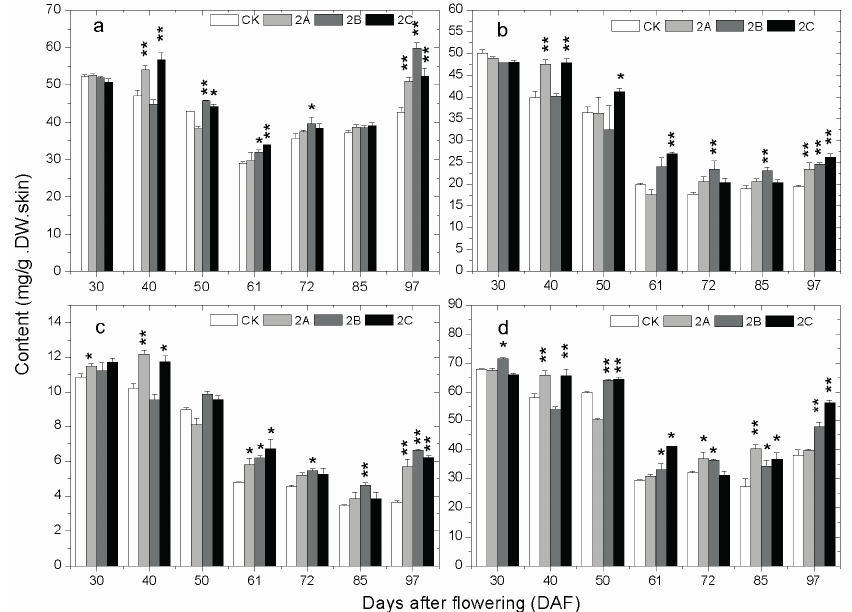
Figure 3. The change of ( a ) total polyphenol; ( b ) total flavonoids; ( c ) total flavanols; and ( d ) condensed tannins content in grape skin with developmental stages in the control and the Zn-treated groups in 2013. The asterisk represents the content in the zinc treatment group is significantly different than the control group at 1% level (for two asterisks) and 5% level (for one asterisk),